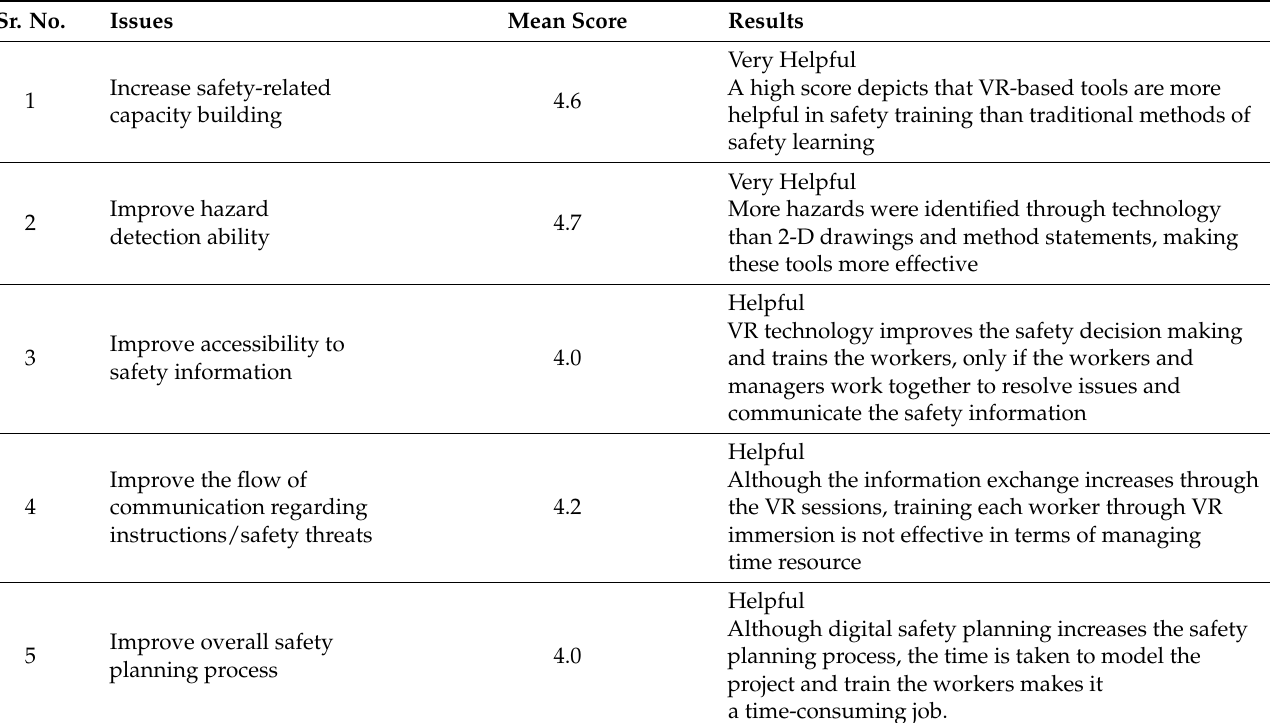
Figure 9. Effectiveness of the VR technology. Table 3. Summary of the mixed-method